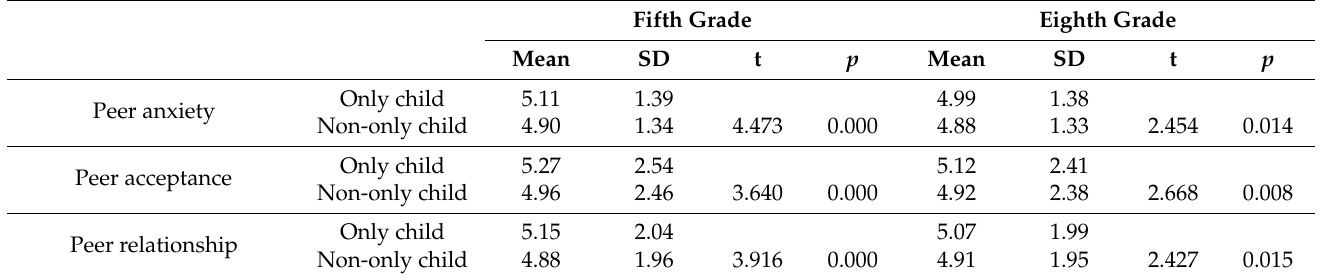
Table 6. Peer relationships dimensions before